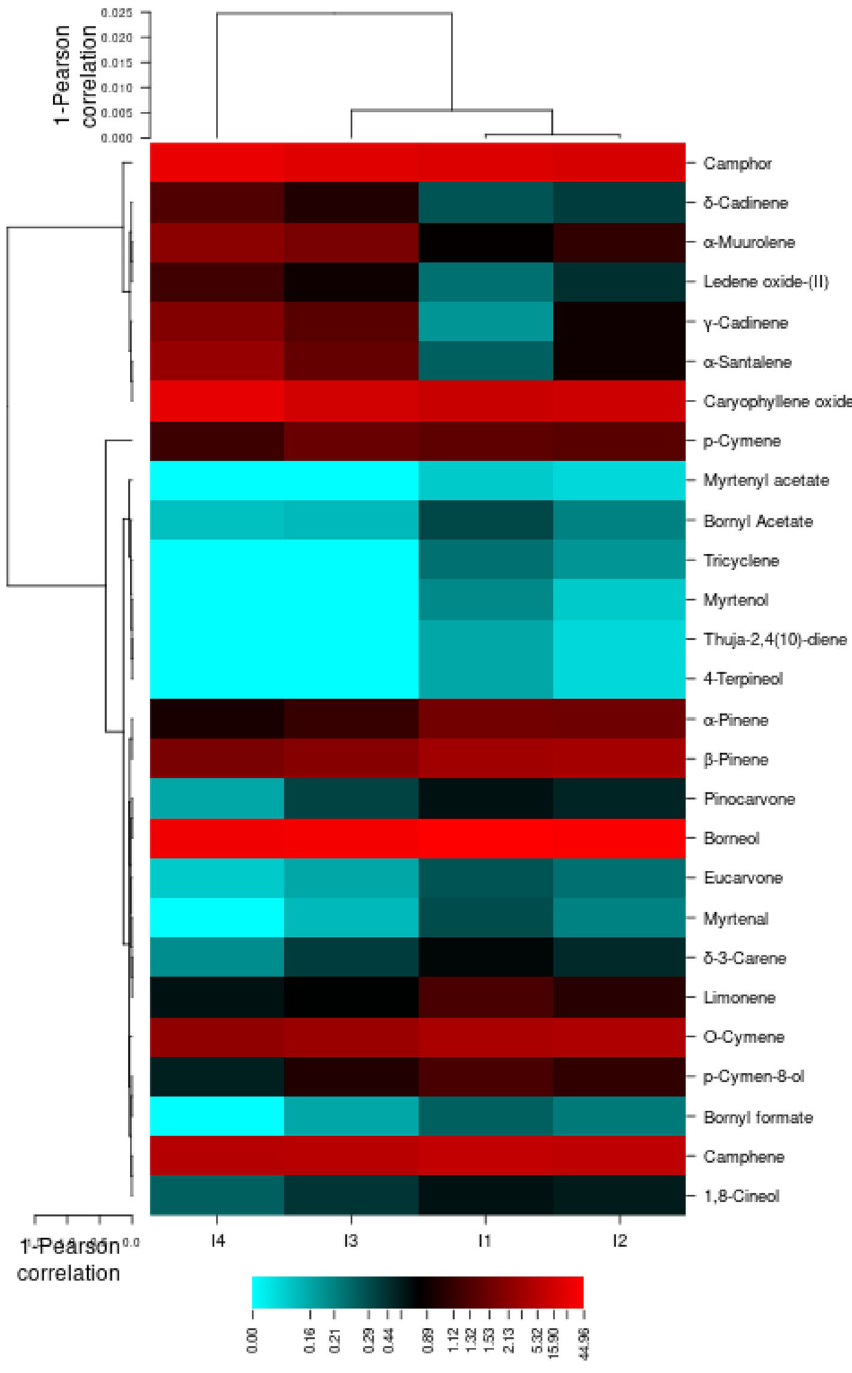
Figure 14. Heatmap for the essential oil profile in aerial parts of Lavandula angustifolia cv. Munstead corresponding to irrigation regimes (CIMminer, https:// disco ver. nci. nih. gov/ cimmi ner/ oneMa trix.